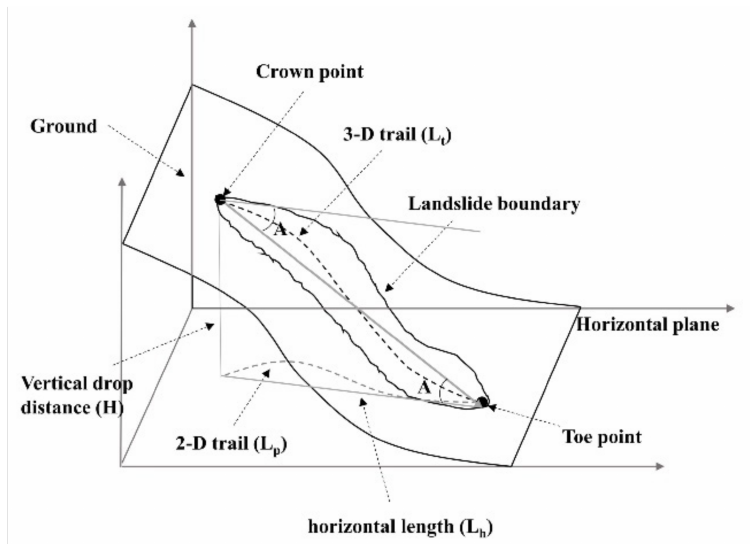
Figure 7. Schematic of landslide trail